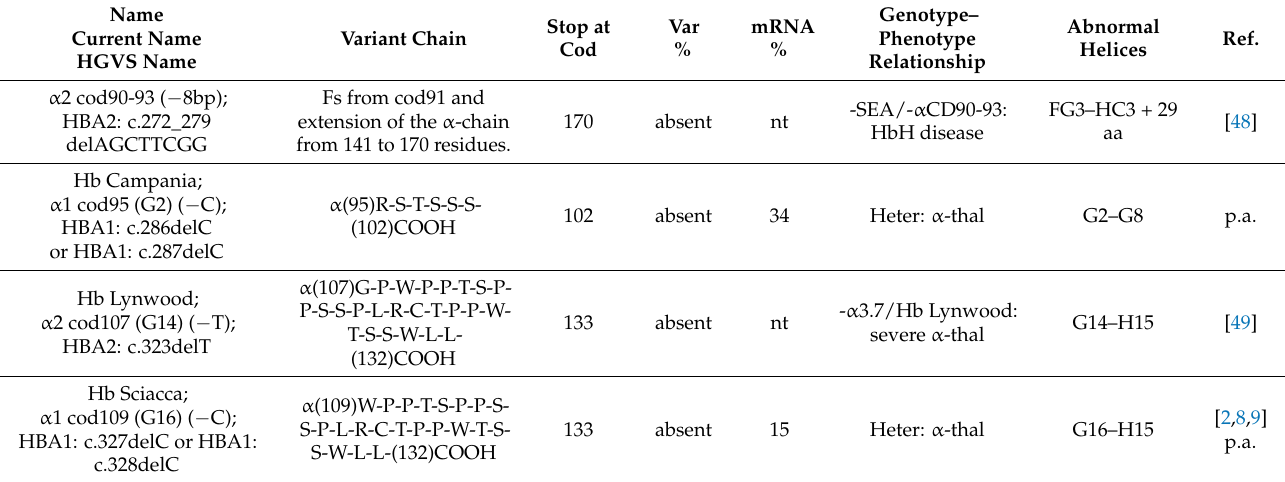
Table 4. Frameshift and stop codon mutations in the third exon of the α -globin